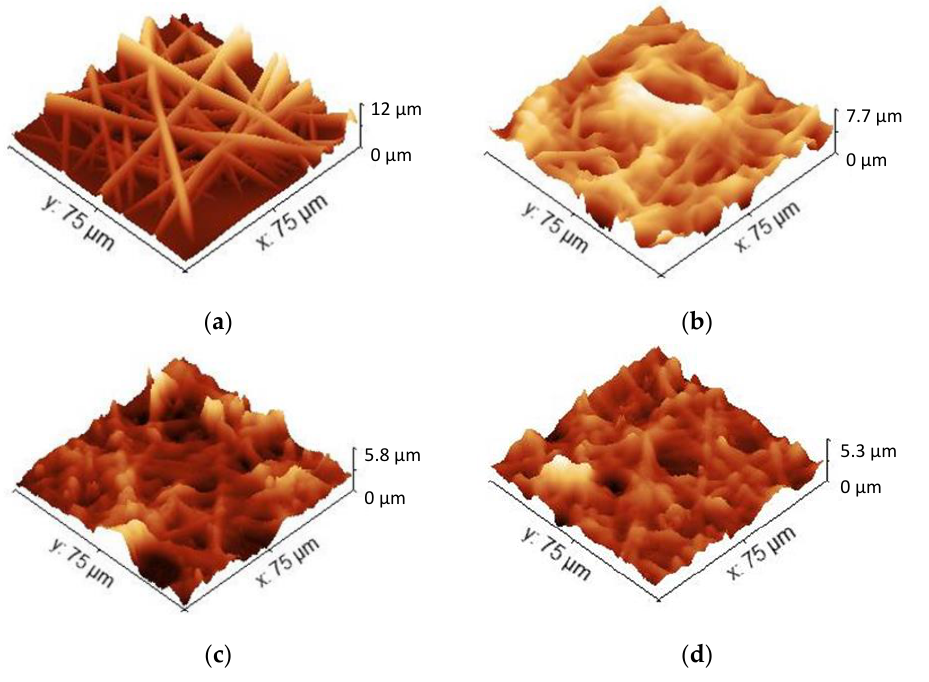
Figure 7. AFM 3D images of the four analyzed samples ( a ) PAA + β -CD; ( b ) PAA + β -CD//TiO 2 /PAA; ( c ) PAA + β -CD//TiO 2 /PAA + WO 3 ; ( d ) PAA + β -CD//TiO 2 /PAA + Fe 2 O 3 . Table 3 lists two different roughness parameters, average roughness (Ra) and root mean square roughness (Rq). The table data allow us to conclude that as the metal oxide particles were added, the roughness was decreased. The roughest sample corresponded to the electrospun fiber mat, without any metal oxides. As the TiO 2 , WO 3 or Fe 2 O 3 particles were added, the roughness decreased because of the increase in fiber diameter. Finally, Figure 8 shows that the thickness of samples increased as the metal oxides were added into the coating.